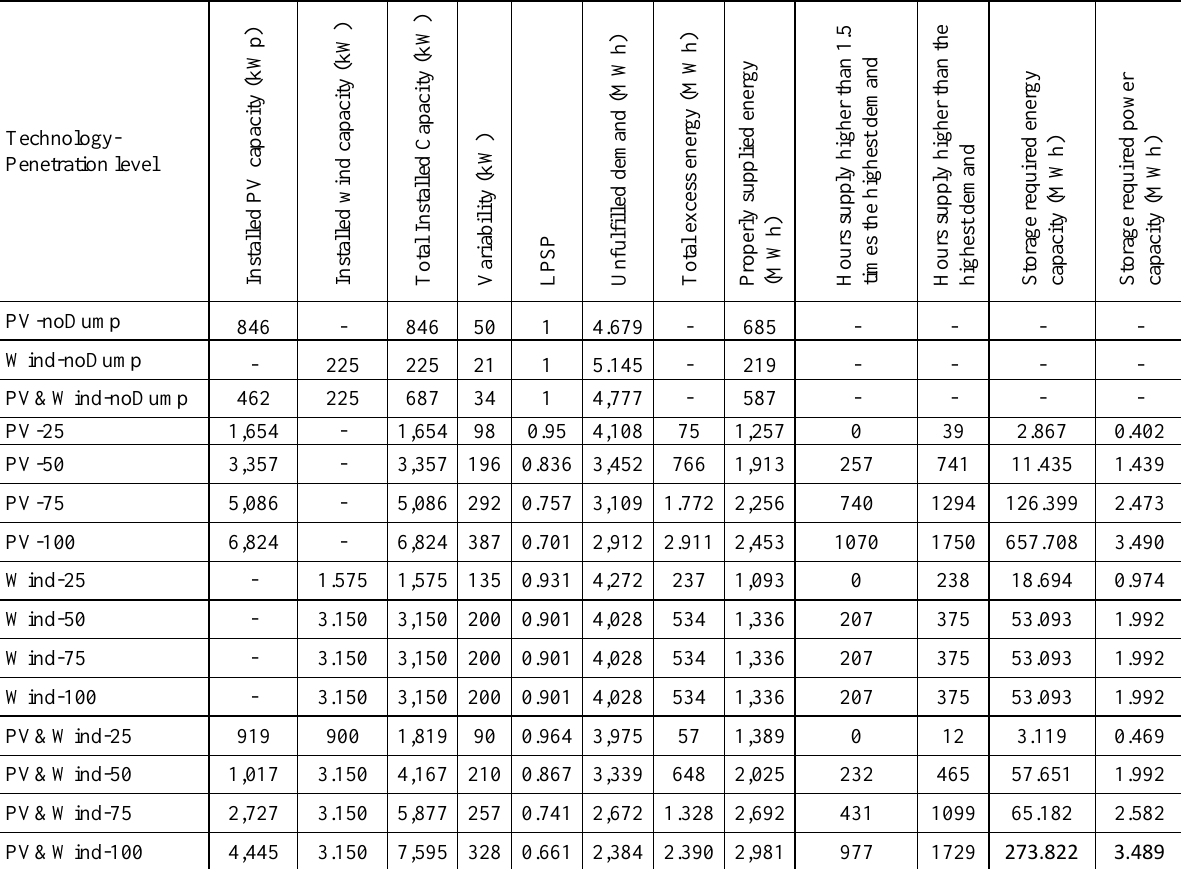
Table 2. Indicators for all solution